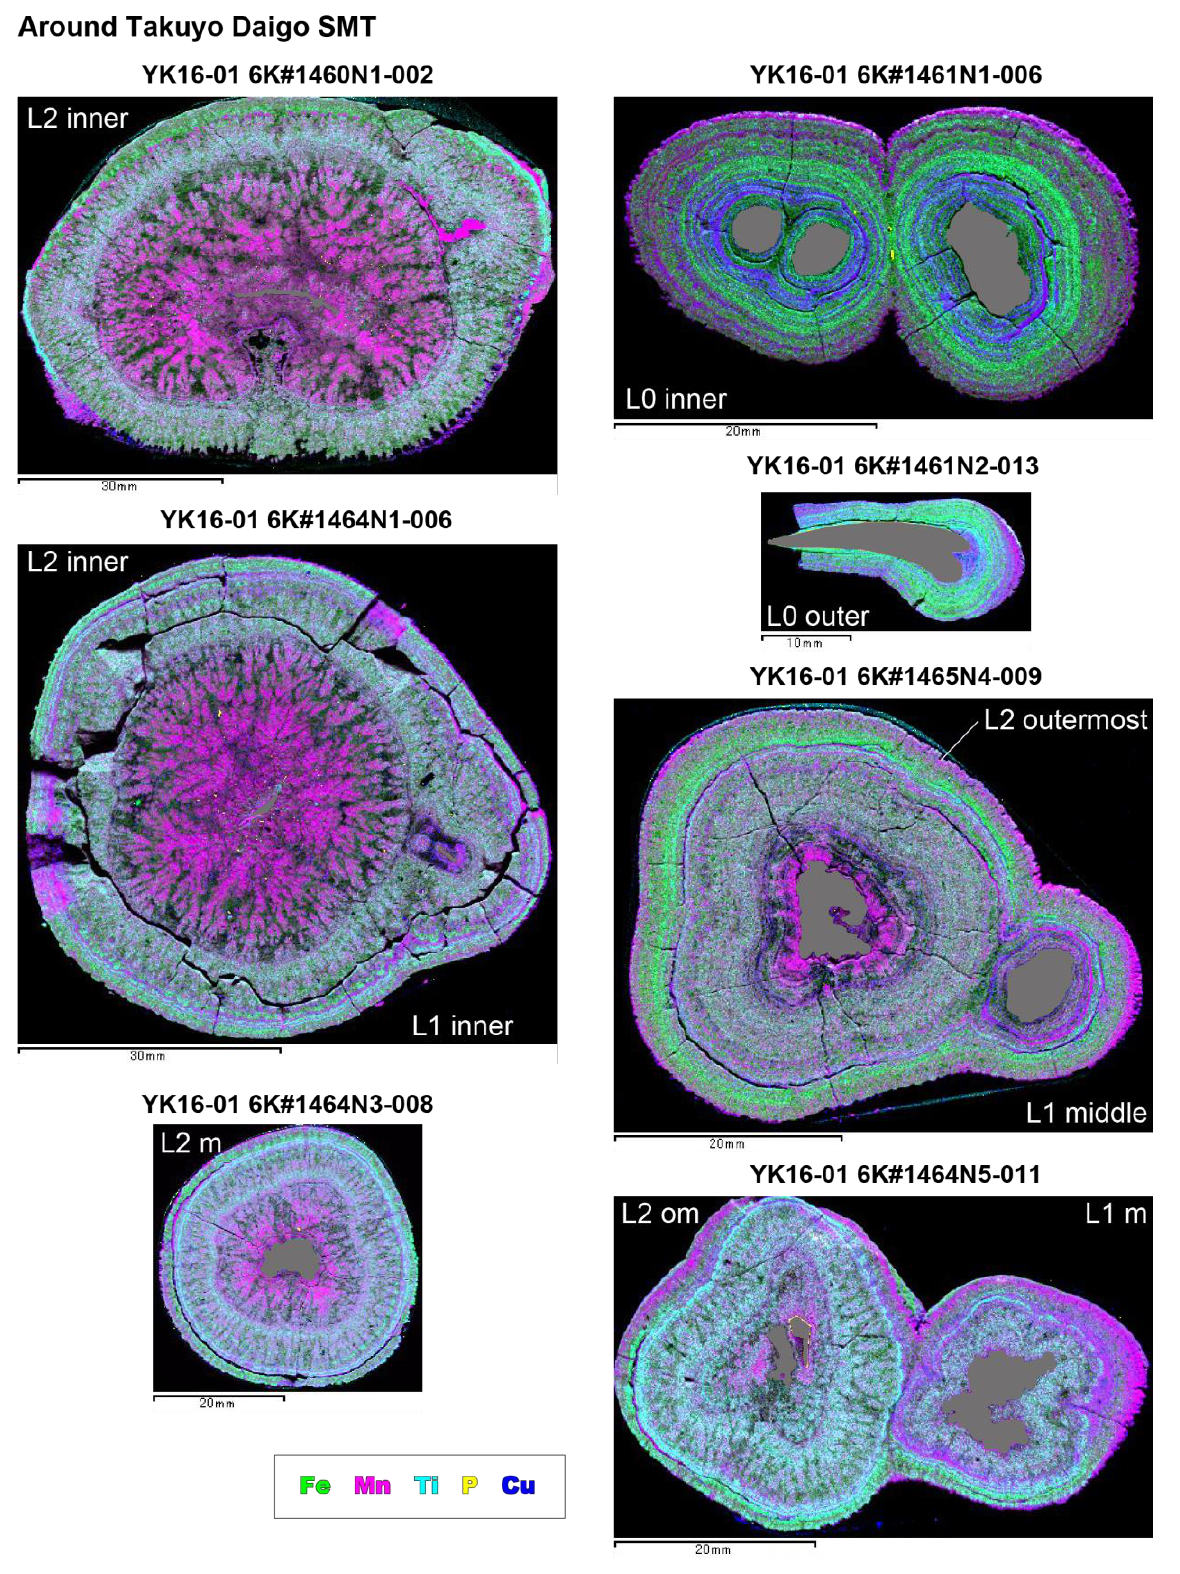
Figure 4. Merged multichemical feature map of the representative samples analyzed in this study. The name of the identified innermost layer around each nucleus is indicated by white text at the corner of panel. The gray field indicates the nucleus(nuclei) of each sample. i: inner; m: middle; o: outer; om: outermost.